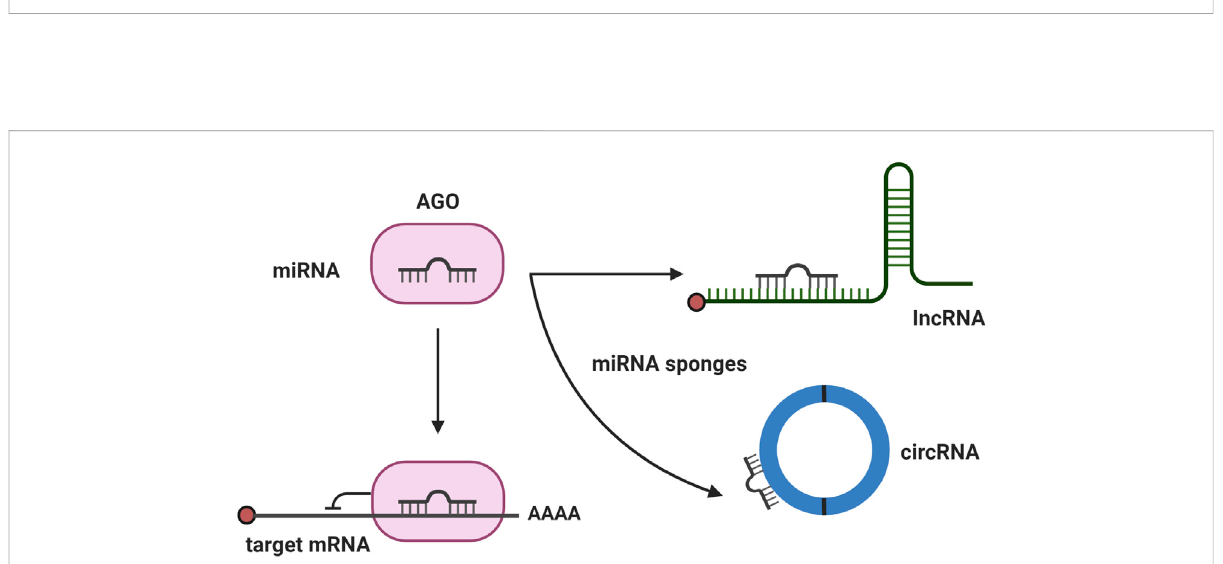
FIGURE 1 Oxygen-induced retinopathy (OIR) animal models. Animal models commonly used to investigate retinopathy of prematurity (ROP) are shown. In an OIR mice model, mouse pups and their mothers are placed in hyperoxia 7 days after birth for 5 days, which mimics phase 1 of ROP in humans. During hyperoxia, shrinkage of newly developed vessels occurs. The animals are then returned to room air (relative hypoxia) for 5 days, which resembles phase 2 of human ROP. During hypoxia, retinal neovascularization (RNV) begins and maximizes at 17 days after birth. In an OIR rat model, ratpupsandtheirmothersareexposedto 50%oxygenonthe fi rstdayand 10%oxygen onthenextday,and thiscycleisrepeated for14 days. Duringthis fl uctuatingoxygenlevelperiod,normalvesseldevelopmentisdelayed.From14to20 days,theratpupsaremovedtoroomair,andRNVis